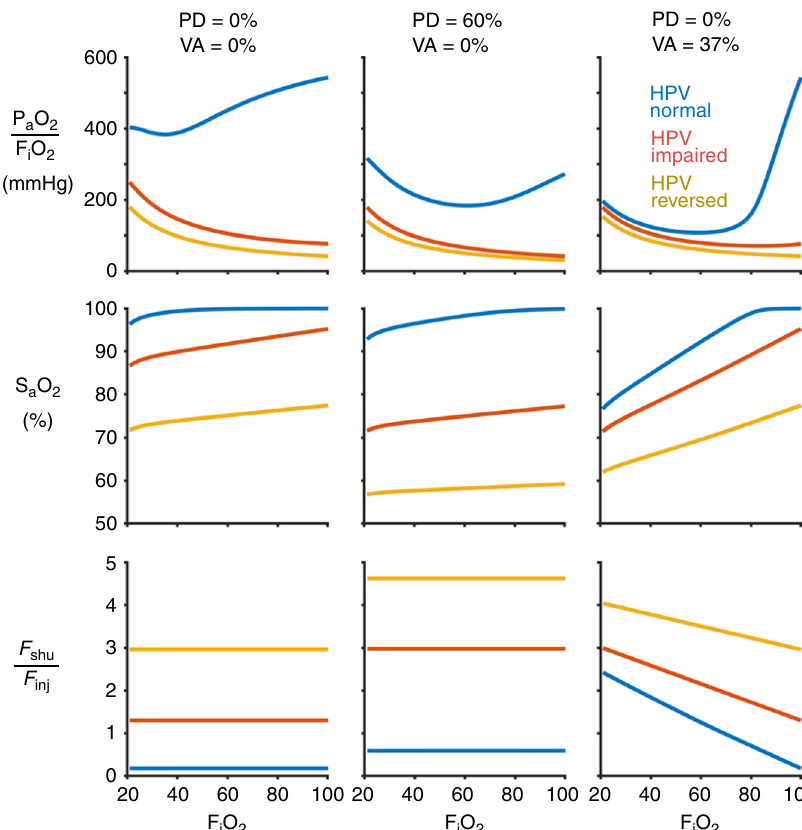
Fig. 7 Predicted response to increased fraction of inspired oxygen ( F i O 2 ). Colors correspond to alterations in hypoxic pulmonary vasoconstriction (HPV) within the injured lung compartments (blue: normal; red: impaired; yellow: reversed). Rows correspond to the ratio of arterial oxygen tension to inspired oxygen fraction ( P a O 2 : F i O 2 ), arterial oxygen saturation of hemoglobin ( S a O 2 ), and ratio of shunt fraction to injured fraction ( F shu : F inj ). Columns correspond to three different cases of perfusion defect in the noninjured lung (PD) and venous admixture owing to ventilation-perfusion mismatching in the noninjured lung at 21% F i O 2 (VA). In all cases, the injured fraction ( F inj ) was 17%, baseline perfusion gradient was 30%, and reversed HPV was modeled with 72% reduction of vascular resistance in injured the P a O 2 : F i O 2 ratio until the mixed arterial blood is fully satu- rated, which does not occur even at 100% F i O 2 for any model with abnormal HPV. Note that the model of ventilation-perfusion mismatching is the only model for which the ratio F shu : F inj is sensitive to changes in F i O 2 , and is also the only model for which